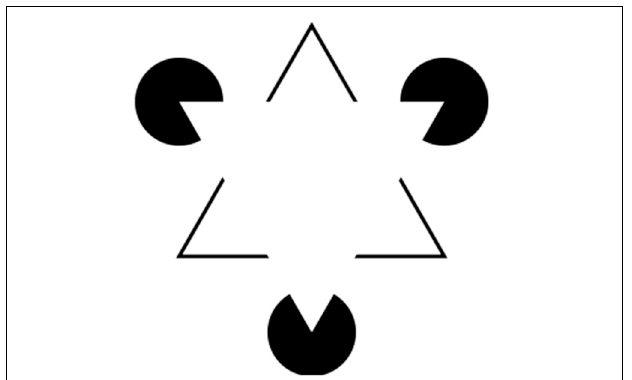
FIGURE 6 | Kanizsa triangle. Here, three black pac-men inducers generate in the brain of the observer the percept of an upside-down white (Kanizsa) triangle. The Kanizsa figure appears to partially occlude three black disks and upright triangular outline whose borders appear to complete behind the Kanizsa triangle. The straight edges of the pac-men induce an illusory contour that completes the borders of the Kanizsa figure. The area of the Kanizsa figure appears somewhat whiter than the regions just outside its borders that have the same luminance in the retinal